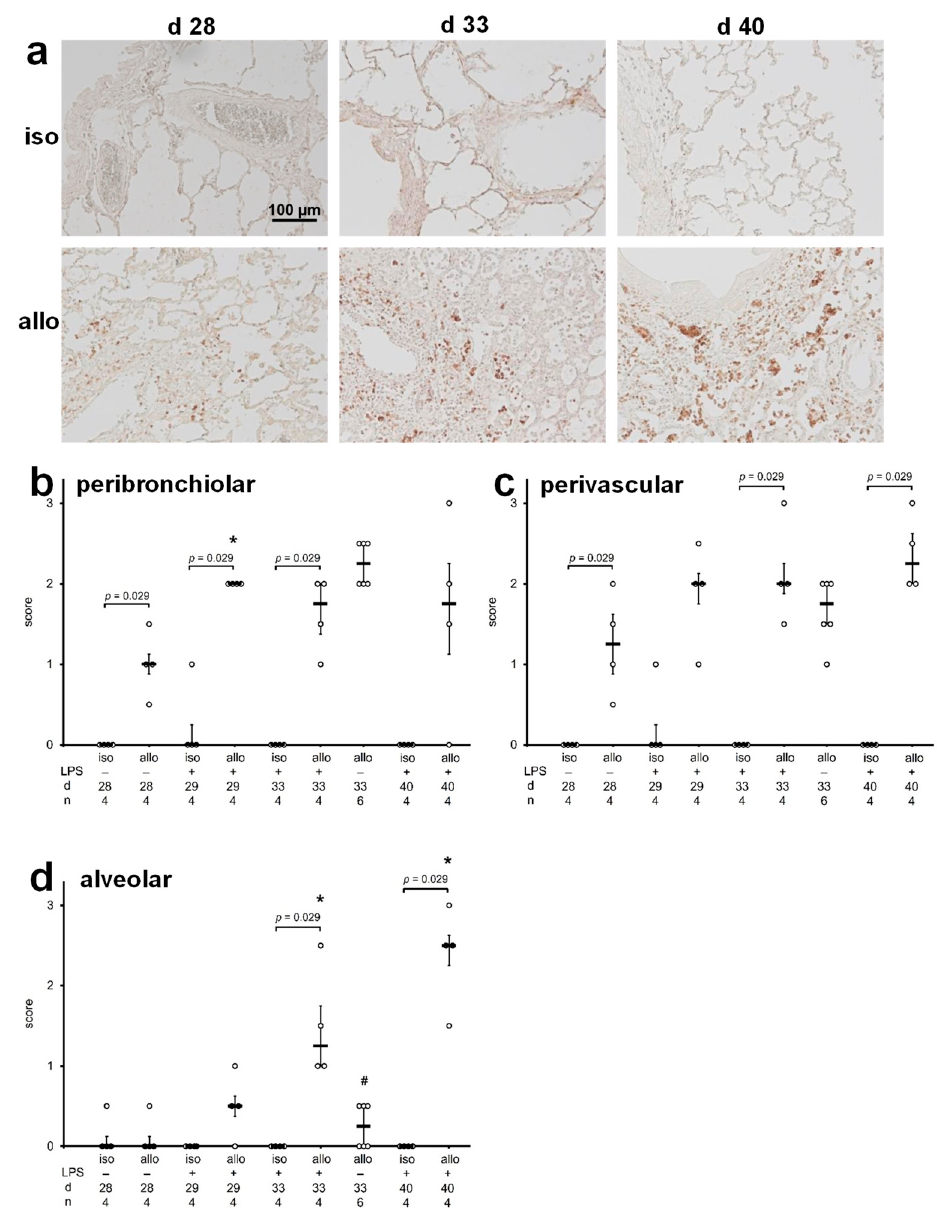
Figure 2. Graft infiltration by B cells. Monoclonal antibody OX33 was used to detect B cells by immunohistochemistry on paraffin sections of pulmonary isografts (iso) and allografts (allo). Grafts were investigated on postoperative day 28 (d 28) before intratracheal instillation of lipopolysaccharide (LPS) or phosphate-buffered saline (PBS), as well as on postoperative days 29 (d 29), 33 (d 33), and 40 (d40), 1, 5 and 12 days after treatment with LPS, respectively. Immunopositive cells are stained in brown, and cell nuclei are lightly counterstained with hemalum ( a ). The intensity of B cell infiltration in peribronchiolar ( b ) perivascular ( c ) and alveolar ( d ) regions was evaluated using a scoring system ranging from 0 for virtually no B cell infiltrates to 3, the strongest infiltrates observed. Data are presented as individual data points, bar represents median, whiskers encompass the 25th to 75th percentile. Explorative data analysis was performed using Kruskal–Wallis test followed by Mann–Whitney U-test; * p ≤ 0.05, different from allo d 28, # p ≤ 0.05 allo d 33 PBS versus allo d 33 LPS.